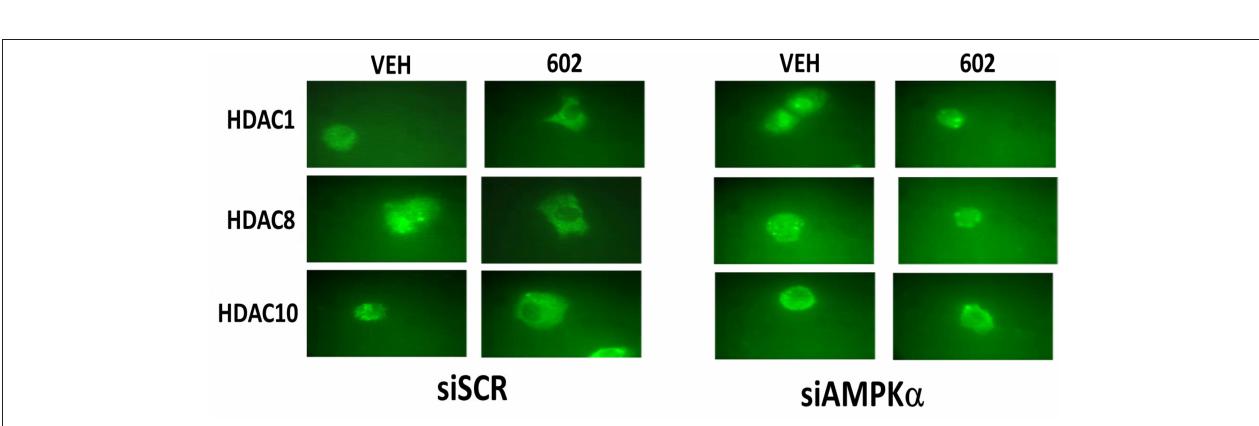
FIGURE 11 | Nuclear exit of HDACs1/8/10 requires signaling by the AMPK. HT1080 cells were transfected with a scrambled siRNA (siSCR) or with an siRNA to knock down the expression of AMPK α . Twenty-four hour afterwards, cells treated with vehicle control or with [GZ17-6.02 (2 µ M final curcumin)] 1h. Cells were fixed in place and immunostaining performed to detect the expression and localization of HDACs1/8/10.